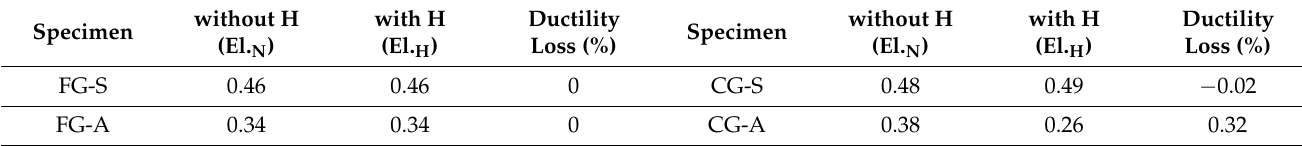
Table 1. Elongation with and without hydrogen charging, and ductility